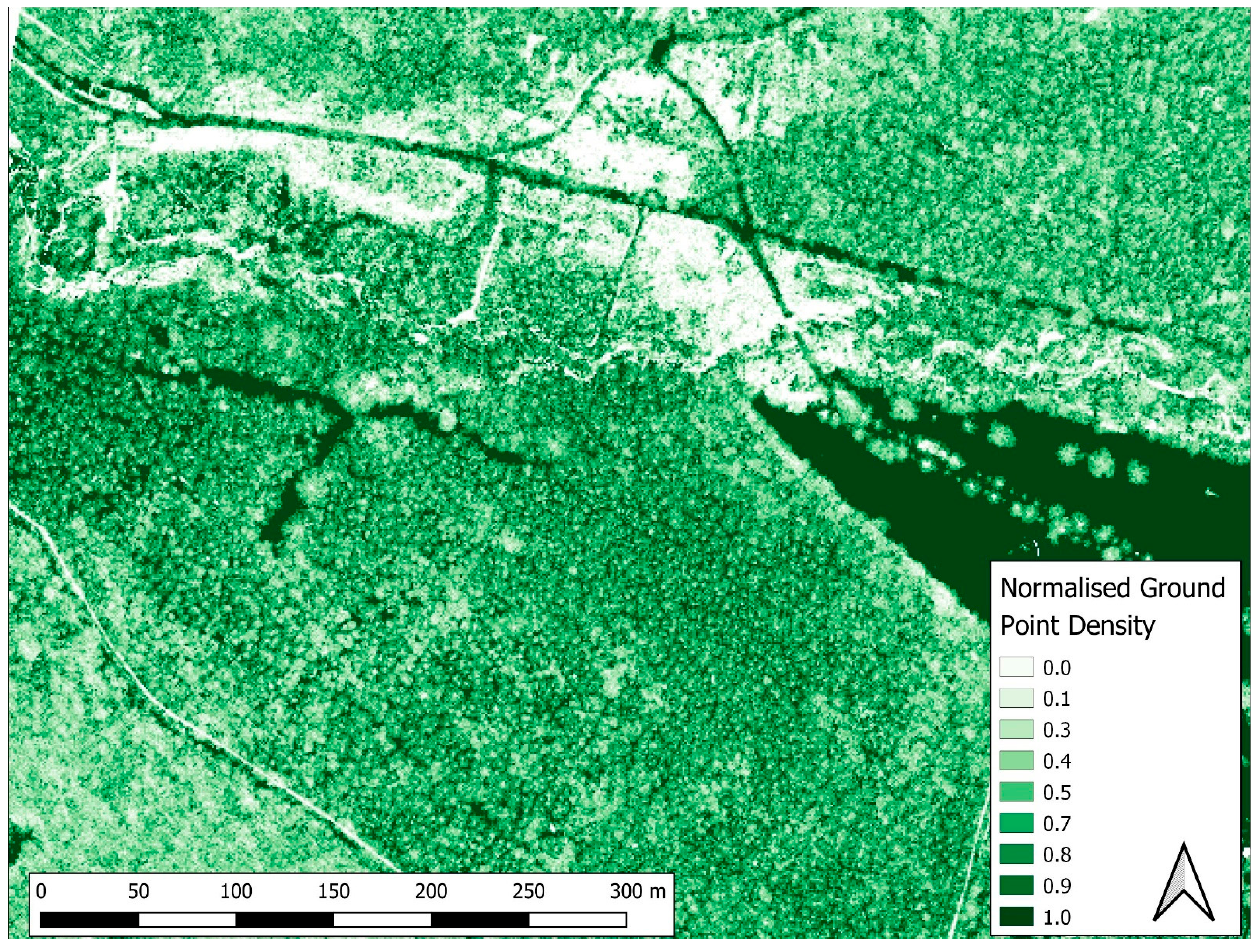
Figure 6. Normalised ground point density map from the data acquired in Spring 2007. Dark tones represent open areas (normalised ground point density = 1), while bright tones indicate dense vegetation.